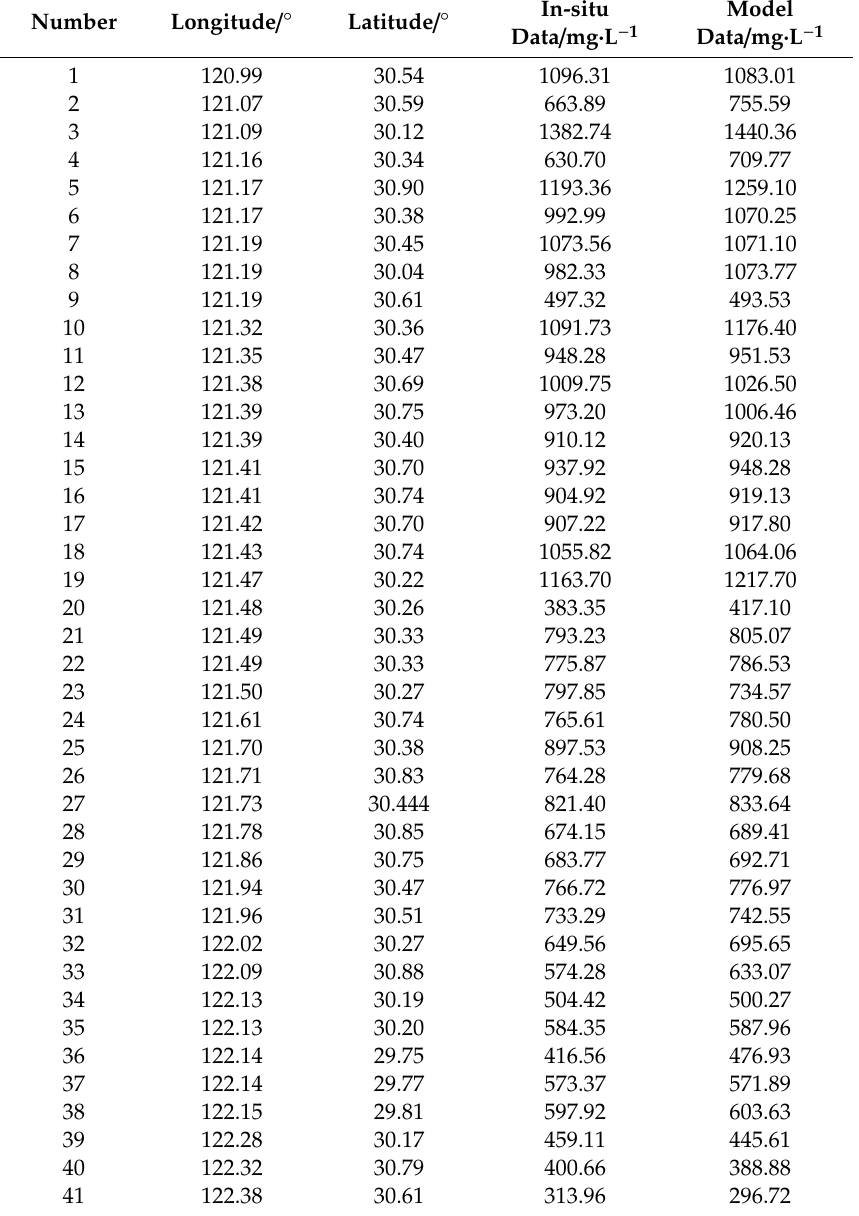
Table 2. In situ data and model data of suspended sediment concentration